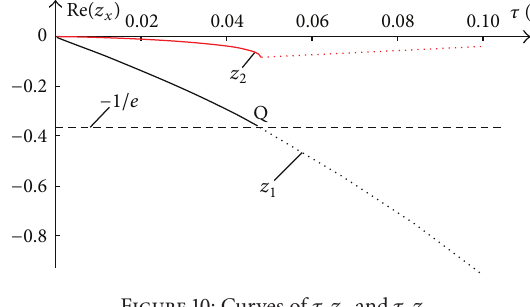
Figure 10: Curves of 𝜏 - 𝑧 1 and 𝜏 - 𝑧 2 .